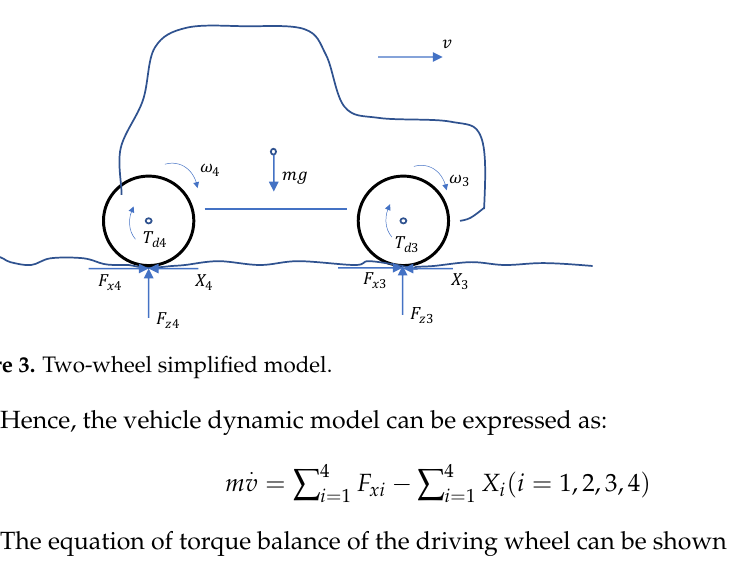
Figure 3. Two-wheel simplified model.